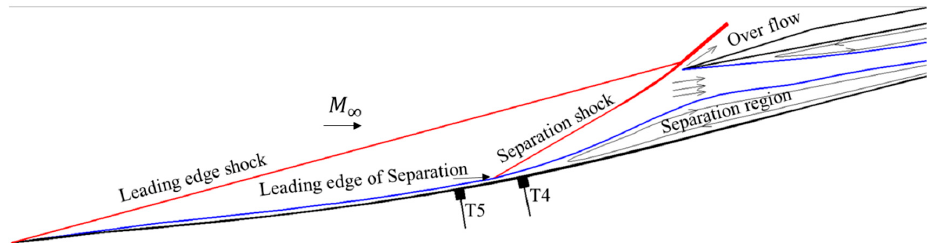
Figure 18. Schematic of the separation flow pattern.